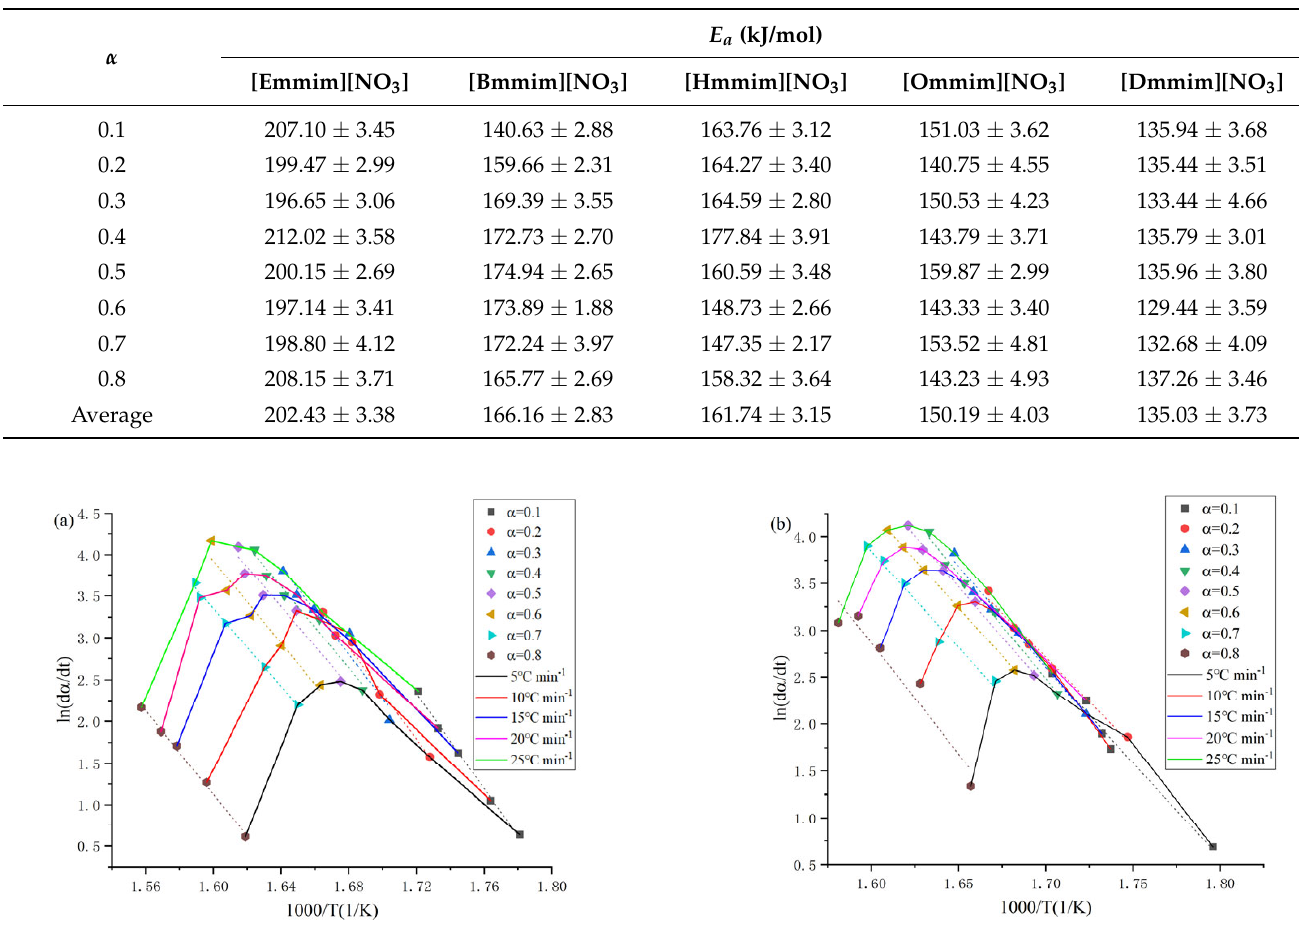
Table 5. The activation energy obtained by the Flynn–Wall–Ozawa method for thermal decomposition of the 1 ‐ alkyl ‐ 2,3 ‐ dimethylimidazole nitrate ionic liquids.